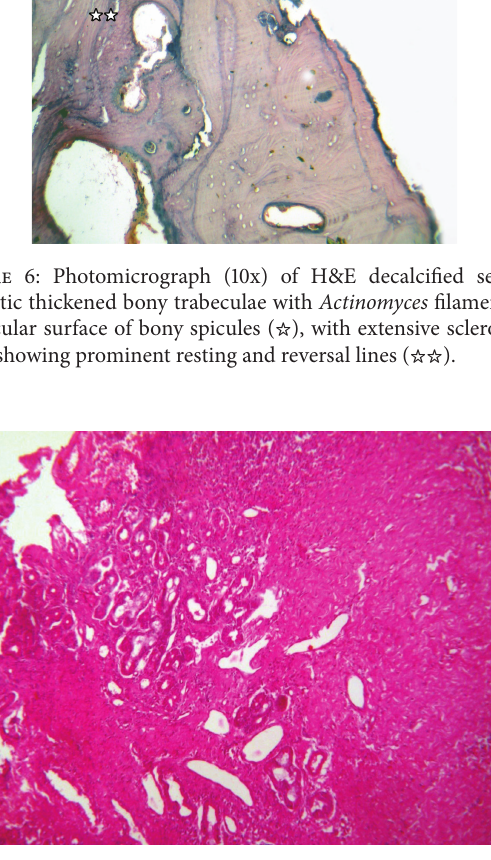
Figure 7: Photomicrograph (10x) H&E section. Extensive fibrosis with granulomas and degeneration of salivary gland